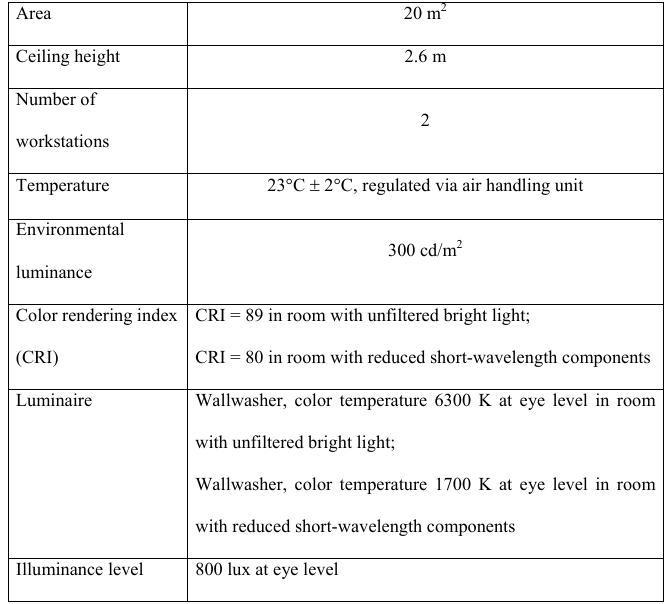
Table 1. Workplace conditions for both unfiltered bright light as well as filtered light with reduced short-wave- length